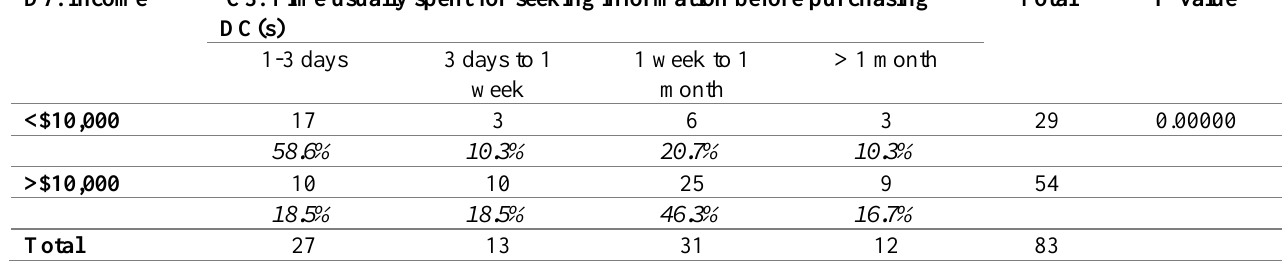
Table 14. Result For Hypothesis